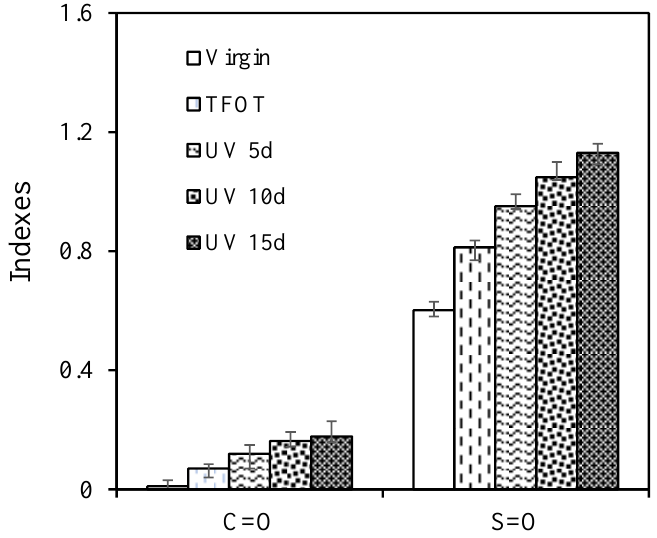
Figure 9. I C=O and I S=O of asphalt after the multiple aging of heat and UV. Table 7. Rangeability of I C=O and I S=O after the multiple aging.